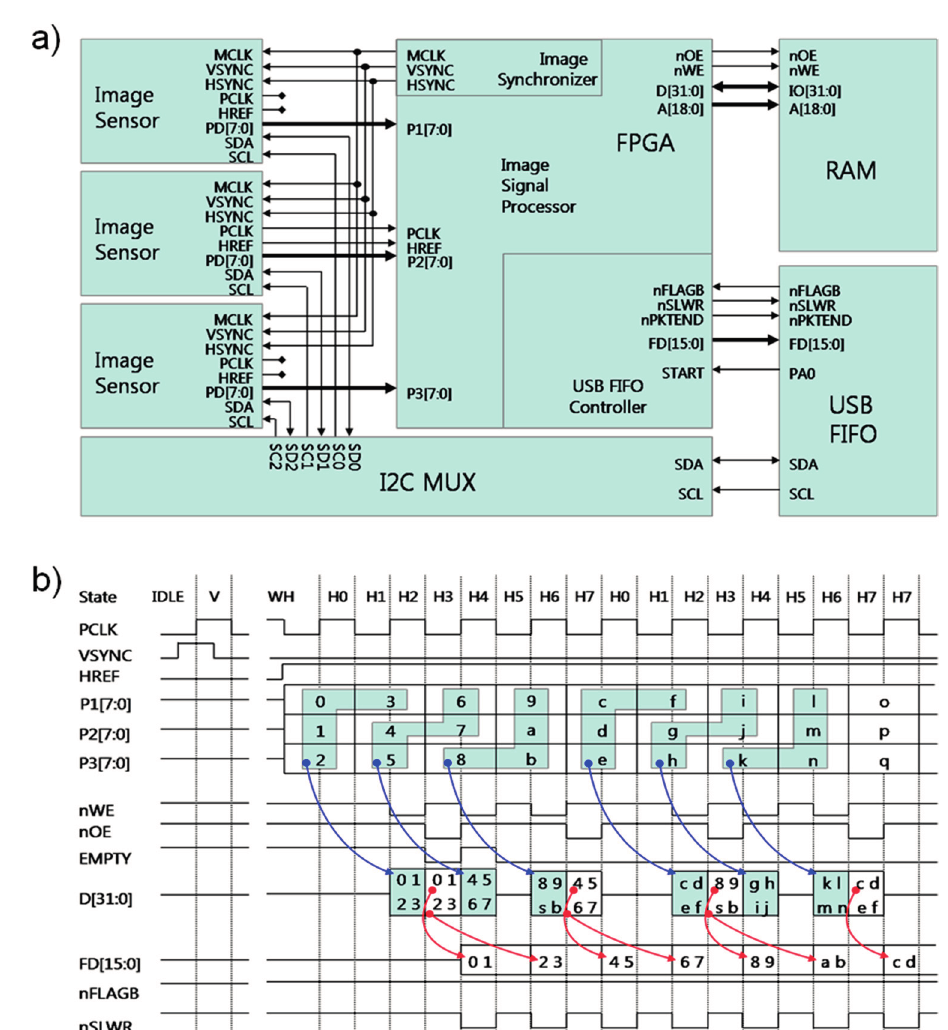
Figure 5. ( a ) Schematic view with 3CCD image sensors, FPGA, RAM, USB FIFO